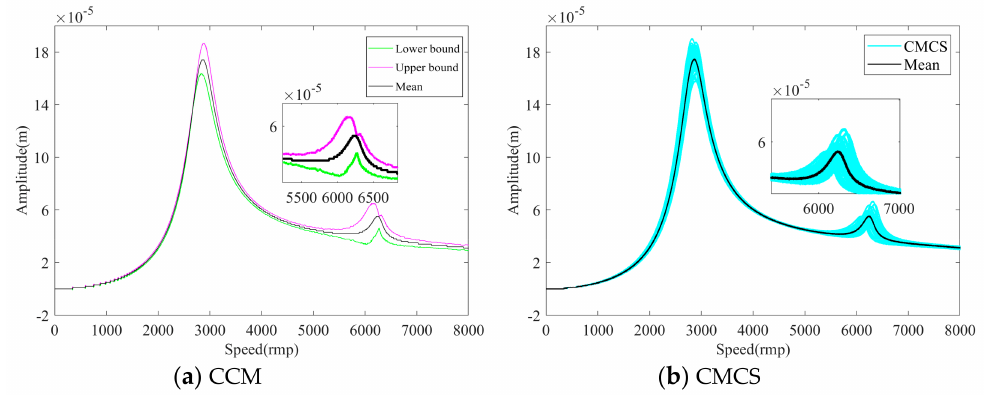
Figure 10. Deflection of the dual-disk rotor with multi − parameters